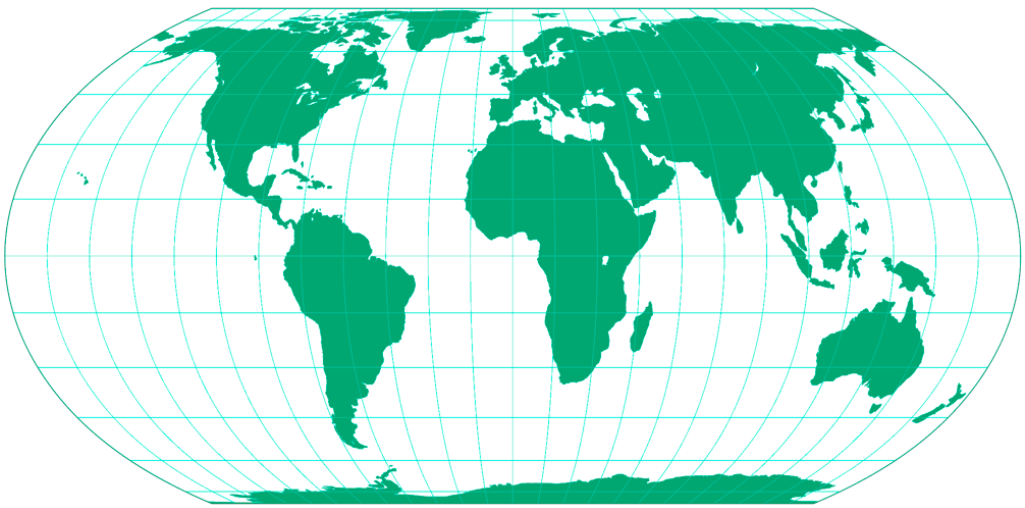
Figure 8. The Equal Earth Projection is an equal area pseudo-cylindrical map projection that is able to preserve the relative size of areas independently of their latitude [27] (By Tobias Jung [CC BY-SA 4.0 (http://creativecommons.org/licenses/by-sa/4.0)], via kartenprojektionen.de).